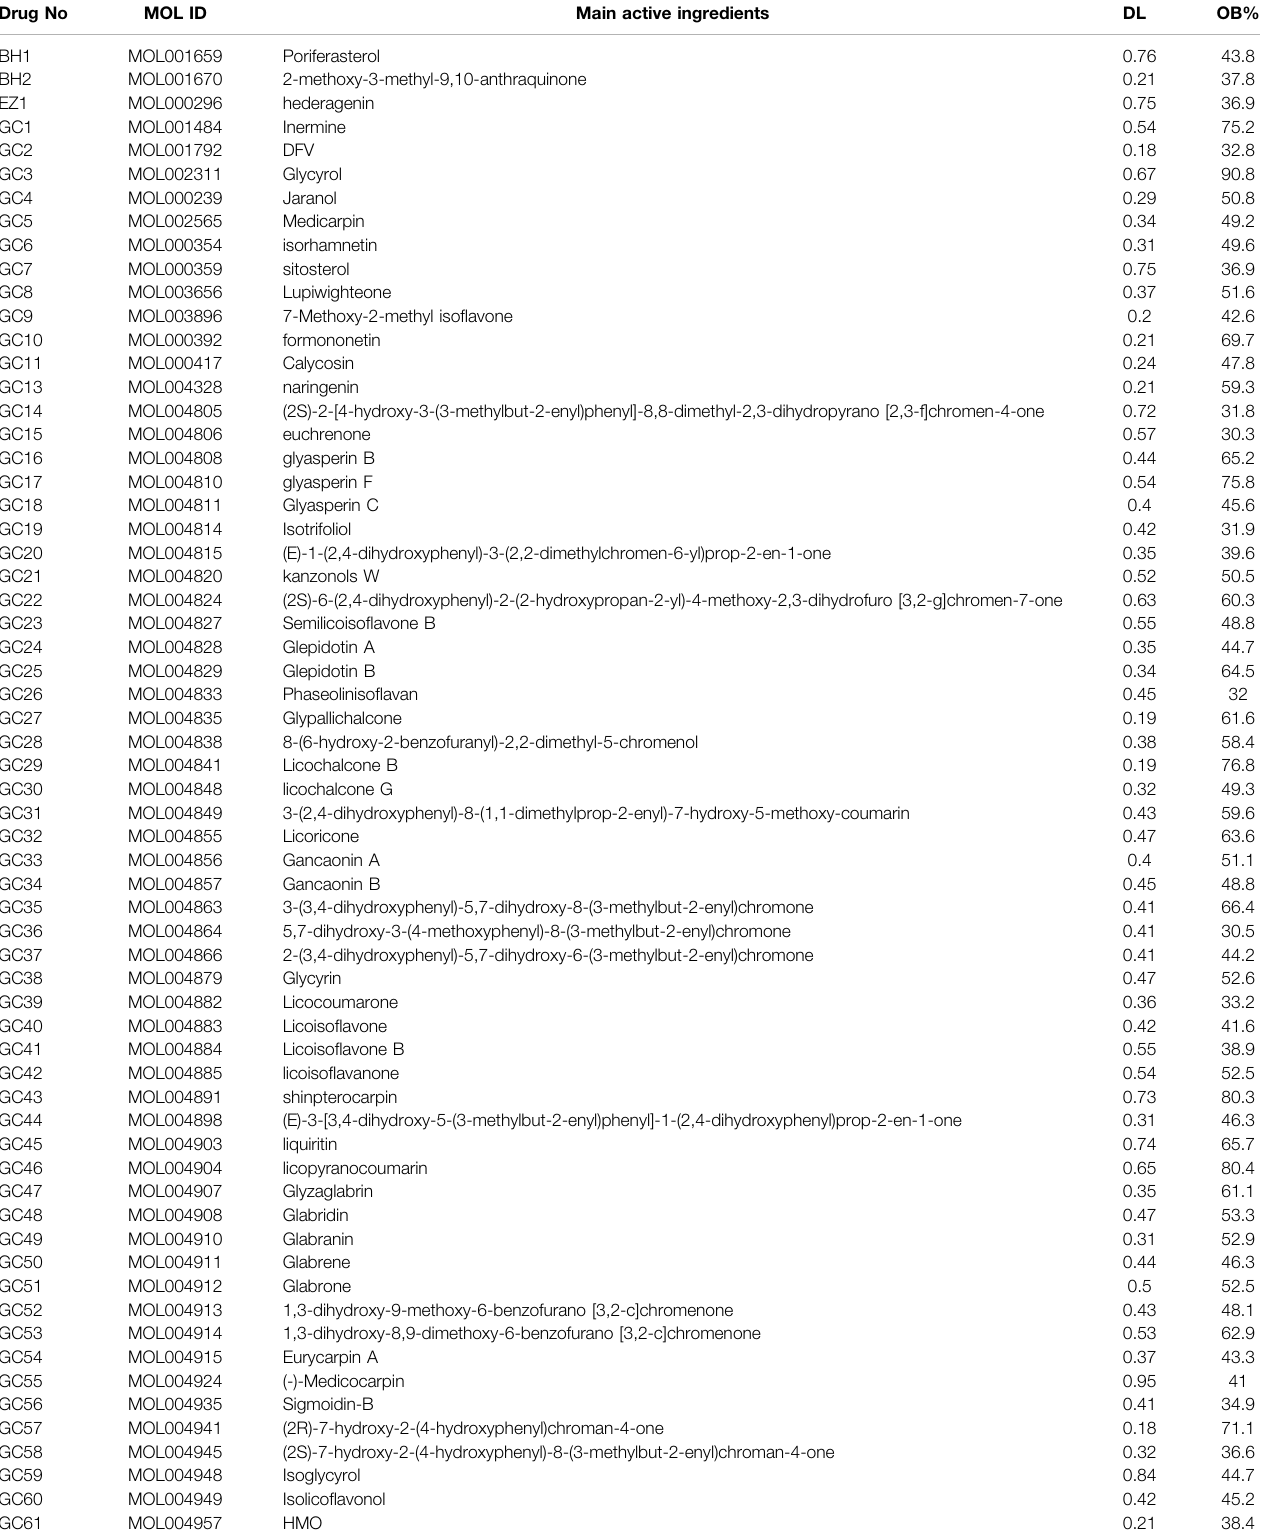
TABLE 2 | Main active ingredients of